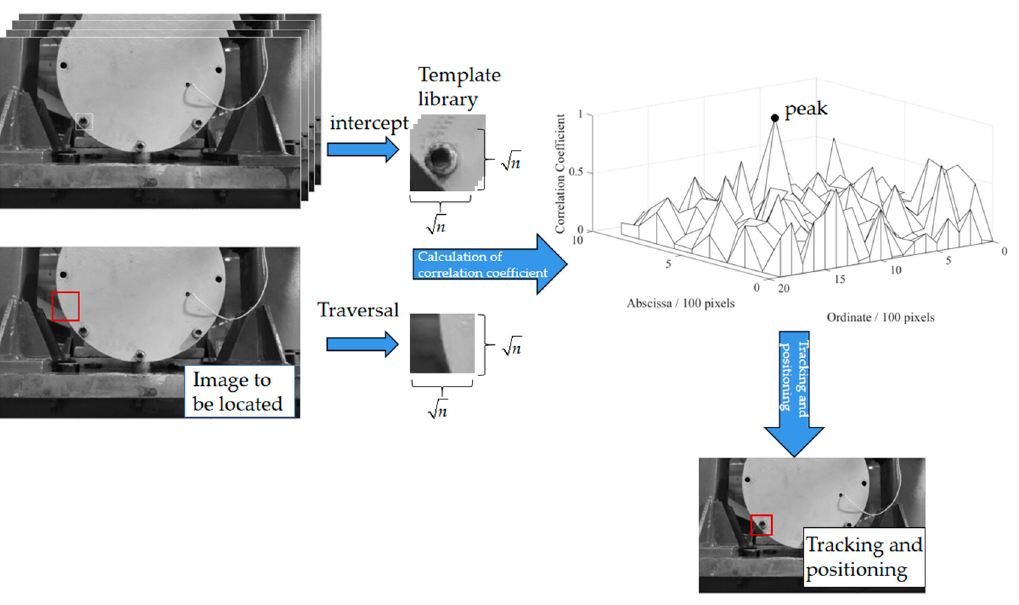
Figure 10. Template matching process.